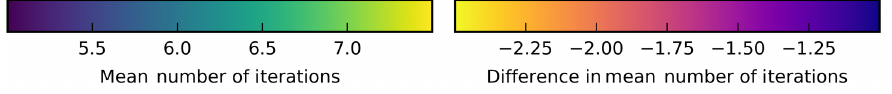
Figure 5. Left column (a, c, e) : maps of average NR iteration numbers for the three different 1-year standard UM Newton–Raphson solver (CNTL) simulations from Table 5; right column (b, d, f) : differences between the quasi-Newton solver (QN2–3) and the equivalent control simulation. The top plots (a, b) are 216-core StratTrop (18EW × 12NS), the middle plots (c, d) are 432-core StratTrop (24EW × 18NS), and the bottom plots (e, f) are 432-core StratTrop + GLOMAP. The quoted statistics are for the simulations and not for the